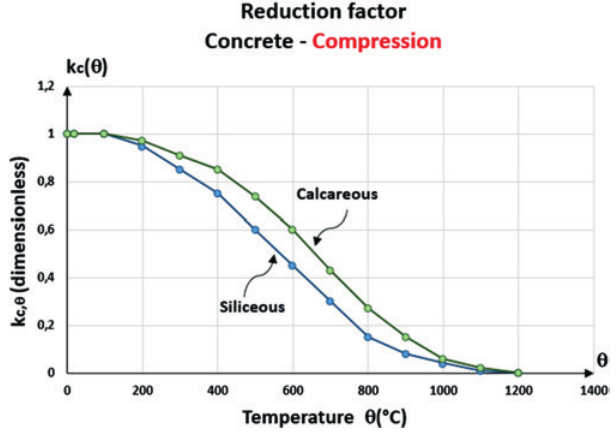
Figure 2 Reduction factor for the compressive strength of concrete, at elevated temperatures